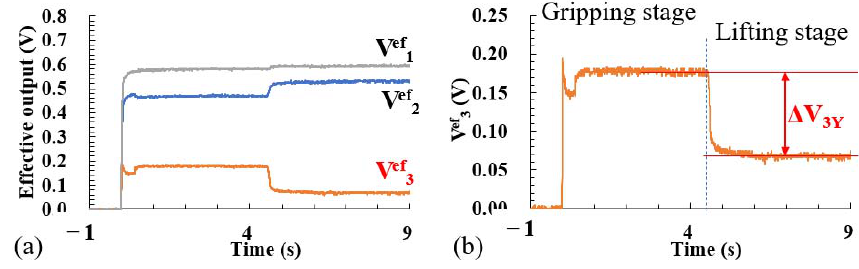
Figure 10. Oscillogram of tactile sensor: ( a ) effective outputs, ( b ) effective output V ef3 .